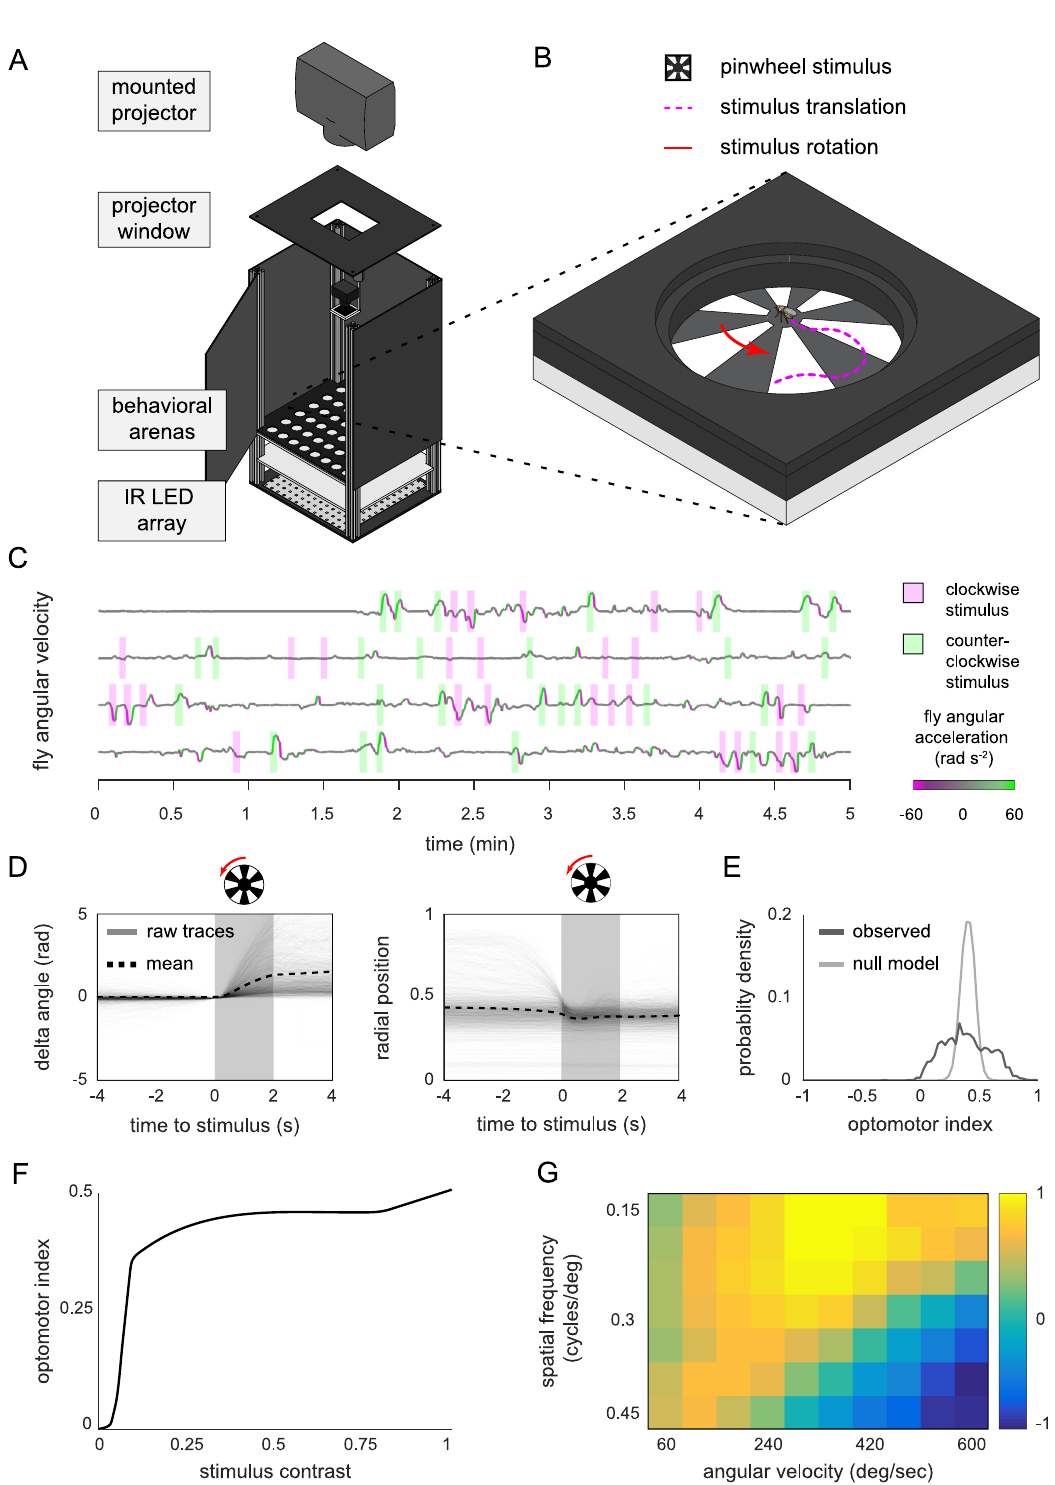
Fig 5. High-throughput optomotor assay implementation in MARGO. A) Schematic of the optomotor arenas and behavioral box. B) Diagram of a single arena and optomotor stimulus. Trials begin with a pinwheel stimulus, centered on the fly. For each trial, the rotational direction (red arrow) of the stimulus is randomized. As the animal moves, the pinwheel position is updated to stay centered on the fly. Trials end when the stimulus is removed after 2s. C) Four sample raw individual angular velocity time series. Flies typically respond to optomotor stimuli by turning in the direction of the rotation of the stimulus. Shaded rectangles